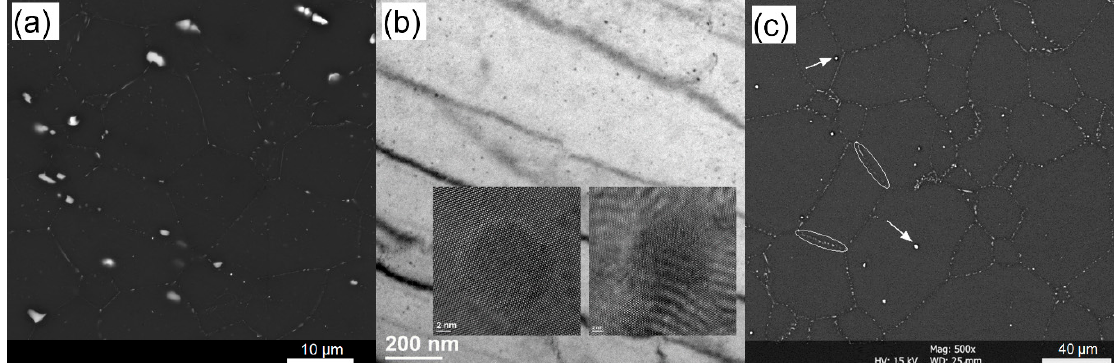
Figure 2. ( a ) SEM Mg2Nd A-series, ( b ) TEM images of precipitates in the heat-treated (150 °C, 7 h) Mg2Nd B-series, <0002> zone axis, ( c ) SEM Mg2Yb A-series.